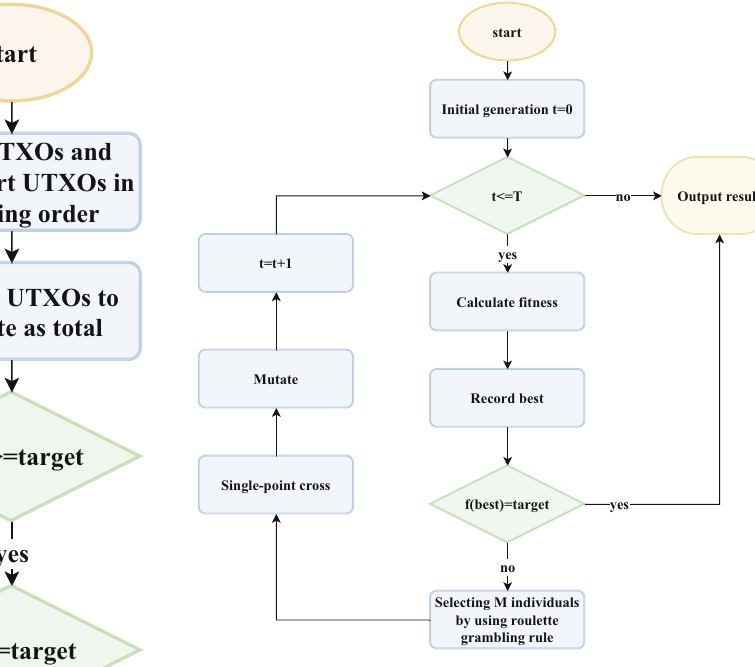
Fig. 6 Flow chart of genetic algorithm